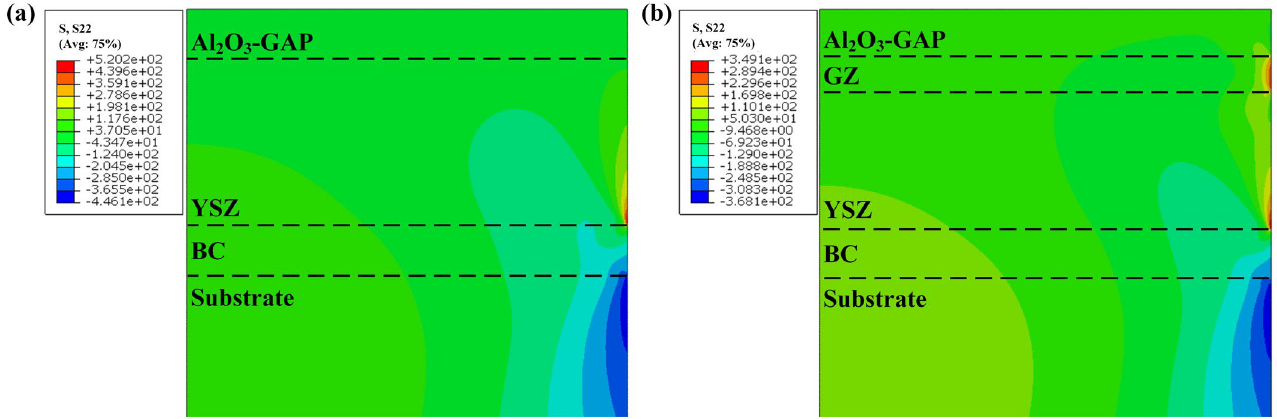
Figure 12. Thermal stress (S22) distribution in TBC system with two kinds of TC design after quenching: ( a ) AGAP-YSZ; ( b ) AGAP-GZ-YSZ.